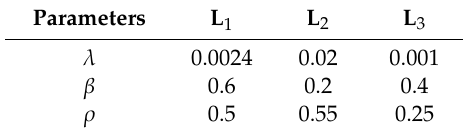
Table 4. Optimal parameter settings of each layer in an S-SAE for the Indian Head